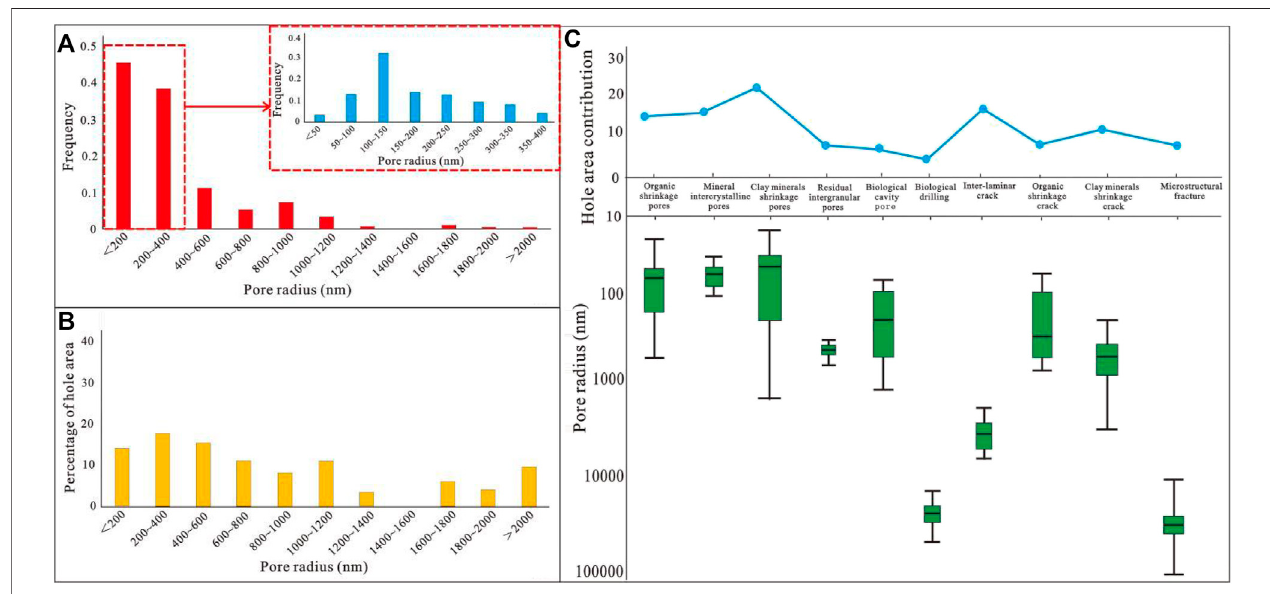
FIGURE 8 | Statistics chart of pore sizes and areas based on Image J processing. (A) Histogram of pore size distribution frequency. (B) Histogram of pore size – pore area proportion distribution. (C) Pore size distribution range boxplot and pore area contribution curve of different pore types.